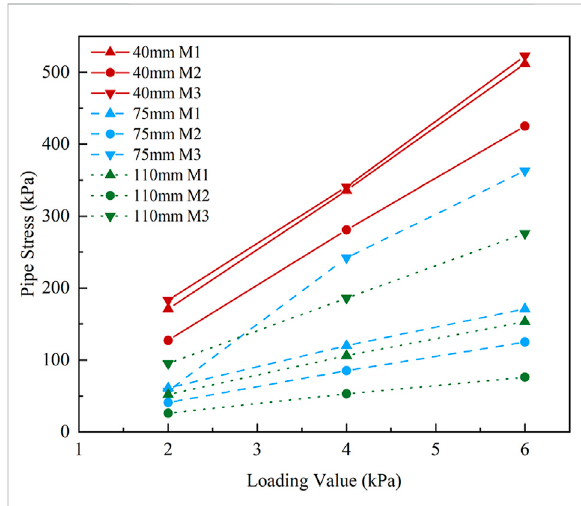
FIGURE 16 Comparison of pipeline stress at M section under different pipe diameters.